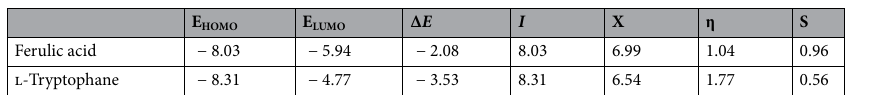
Table 8. Quantum chemical parameters (eV) for the optimized structure of Ferulic acid and l-Tryptophan obtained using DFT with the B3LYP/6-311G(+).